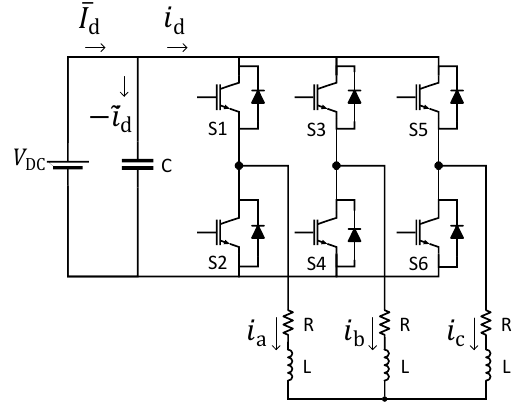
Figure 1. Three-phase VSI